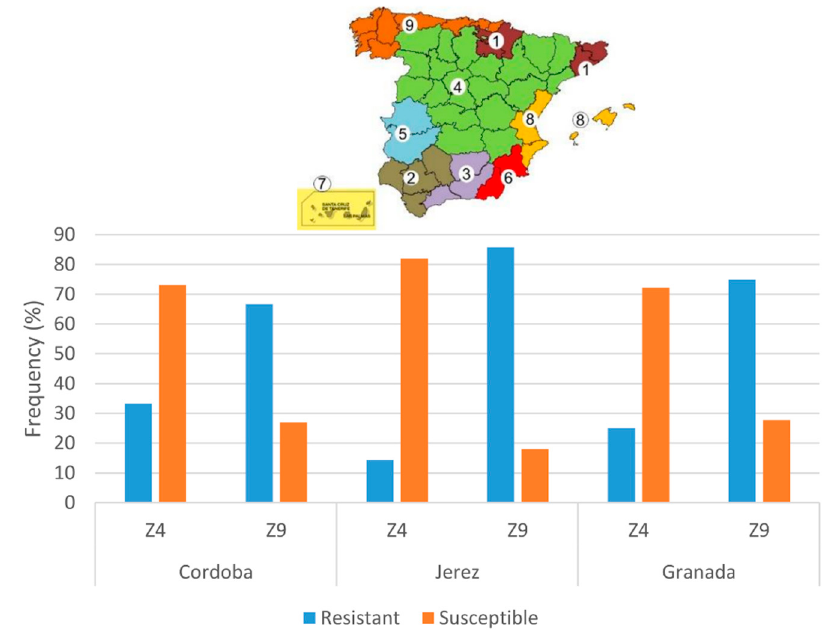
Figure 3. Frequency of leaf rust-resistant landraces from the agroecological zones Z4 and Z9 (defined by [25]) evaluated at the adult plant stage at three locations (Cordoba, Jerez, and Granada).